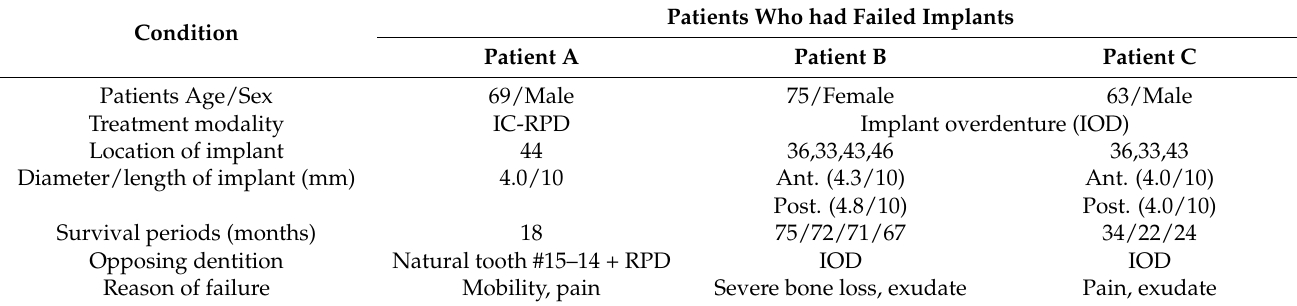
Table 3. The specific information of the 8 failed implants.